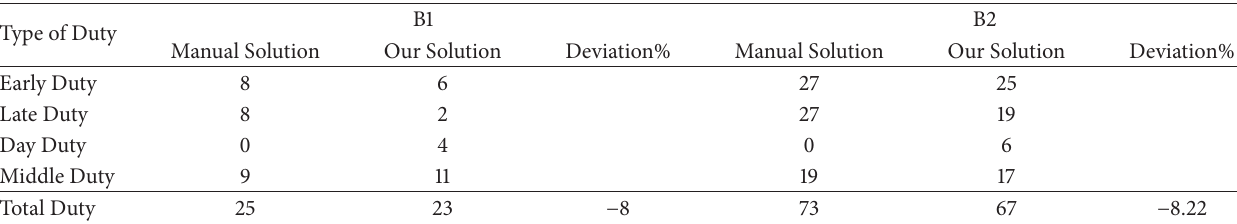
Table 4: Comparison with manual